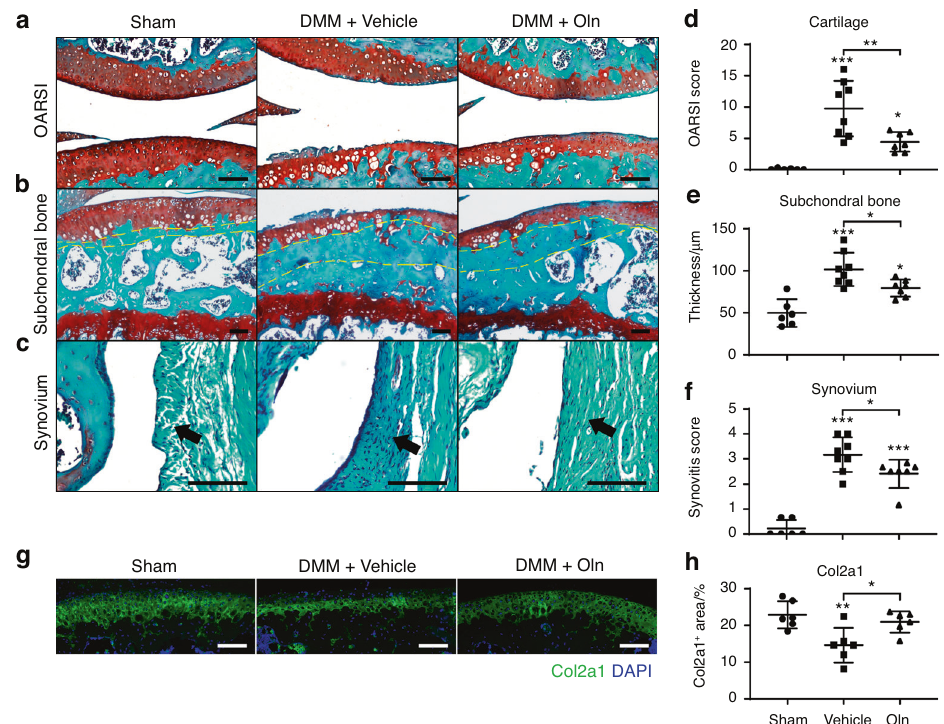
Fig. 8 rOln ameliorates joint symptoms after the onset of OA. a – c Safranin O/Fast Green staining in wild-type mice treated with rOln or vehicle after DMM surgery. Weekly intra-articular administration of rOln (240 μ g·kg − 1 body weight) or vehicle (0.05 mg·mL − 1 hyaluronic acid) was performed 4 weeks after DMM surgery in 10-week-old mice and continued for 8 weeks before paraf fi n sectioning and safranin O/fast green staining of the knee joints. Representative cartilage erosion ( a , top: femur, bottom: tibia), subchondral bone thickening ( b ) and synovitis ( c ) images are shown ( n = 6 – 8 mice per treatment). Yellow dotted lines indicate the subchondral bone plate. Arrows indicate the synovium. Scale bars: 100 μ m. d – f Quanti fi cation of the OARSI score ( d ), subchondral bone thickness ( e ) and synovitis score ( f ). g , h Immunostaining of Col II in the knee joints ( g ) with quanti fi cation ( h ) ( n = 6 mice per treatment). DAPI staining indicates the nucleus. Scale bars: 100 μ m. The statistical signi fi cance was assessed using one-way ANOVAs with Tukey ’ s multiple comparison tests. Data are presented as the mean ± SD (* P < 0.05, ** P < 0.01, *** P < 3 days after DMM surgery for a total of 8 weeks. Histomorphometry analysis showed signi fi cantly decreased cartilage erosion, sub- chondral bone thickening, and synovitis compared to vehicle controls (Fig. S12a – f), which was con fi rmed by Col2a1 staining of articular cartilage (Fig. S12g, h). To test whether rOln could ameliorate articular symptoms after the onset of OA, we administered weekly intra-articular injections of rOln or vehicle control in wild-type mice 4 weeks after DMM surgery for a total of 8 weeks. The vehicle-treated DMM group showed profound cartilage erosion, subchondral bone thickening and synovitis compared to the sham-operated group, and these effects were signi fi cantly ameliorated in the rOln-treated group (Fig. 8a – f). Similar results were obtained by immunostaining of Col2a1 in articular cartilage (Fig. 8g, h). Taken together, these data showed that intra-articular rOln administration signi fi cantly attenuated OA progression.